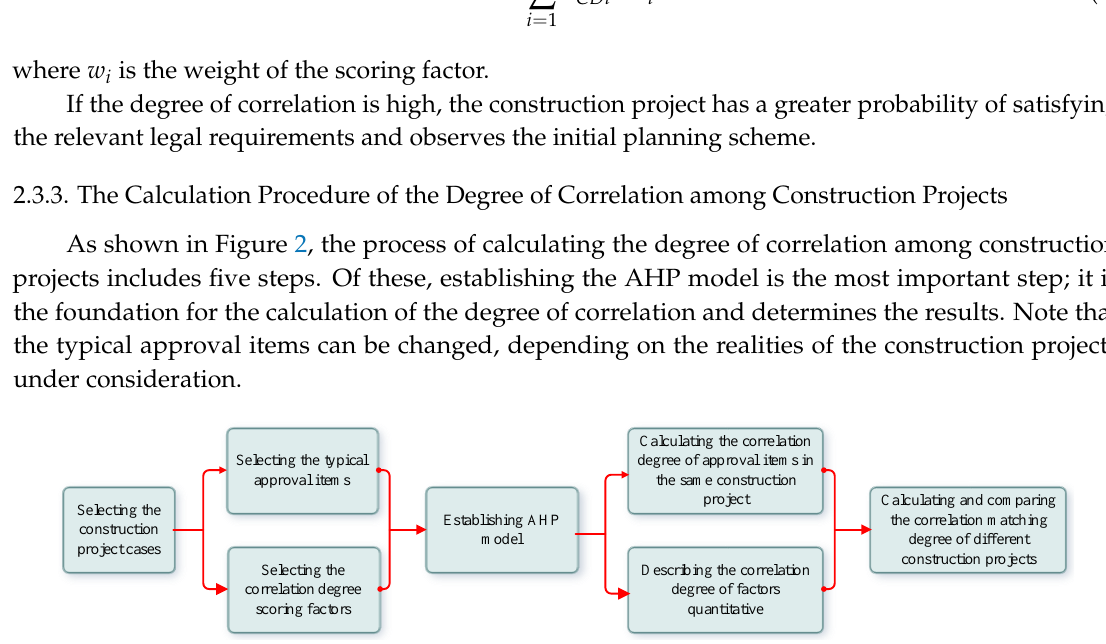
Figure 2. The calculation procedure of the degree of correlation among construction projects.